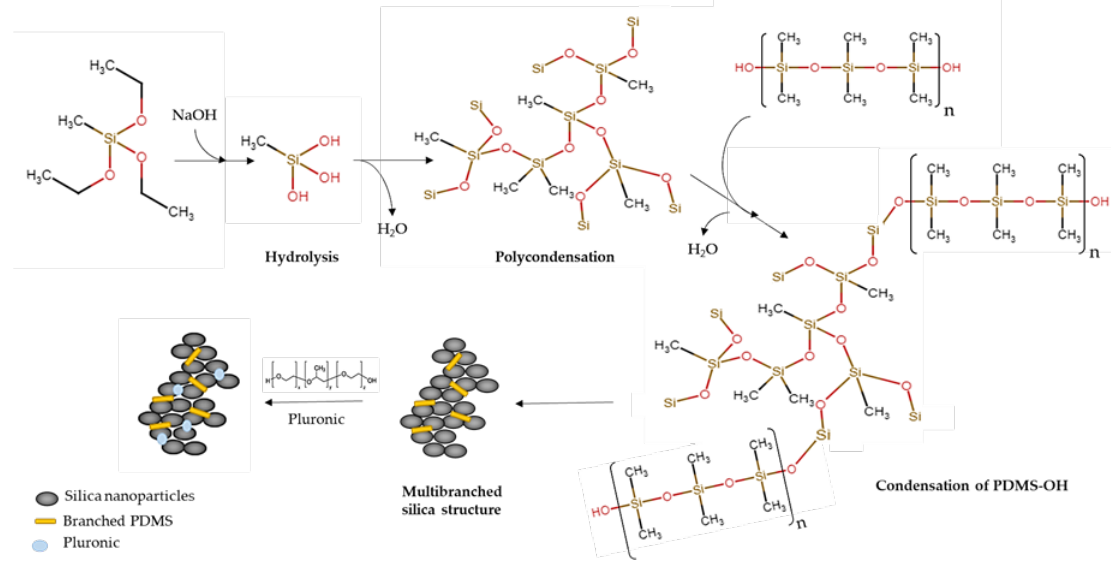
Figure 4. reaction between MTEOS, PDMS-OH and Pluronic. Figure 4. Reaction between MTEOS, PDMS-OH and